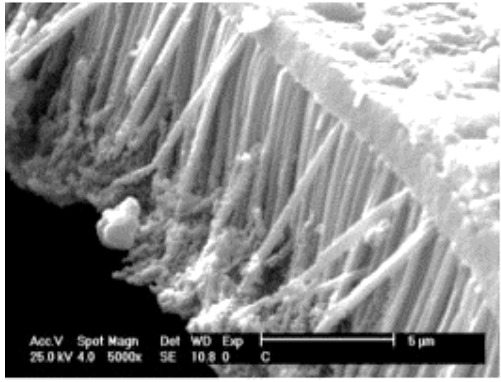
Figure 9. SEM image of PPy nanostructured array prepared by chemical synthesis in AAO template after its dissolving. Reprinted from [98]. Copyright (2017), with permission from Elsevier.